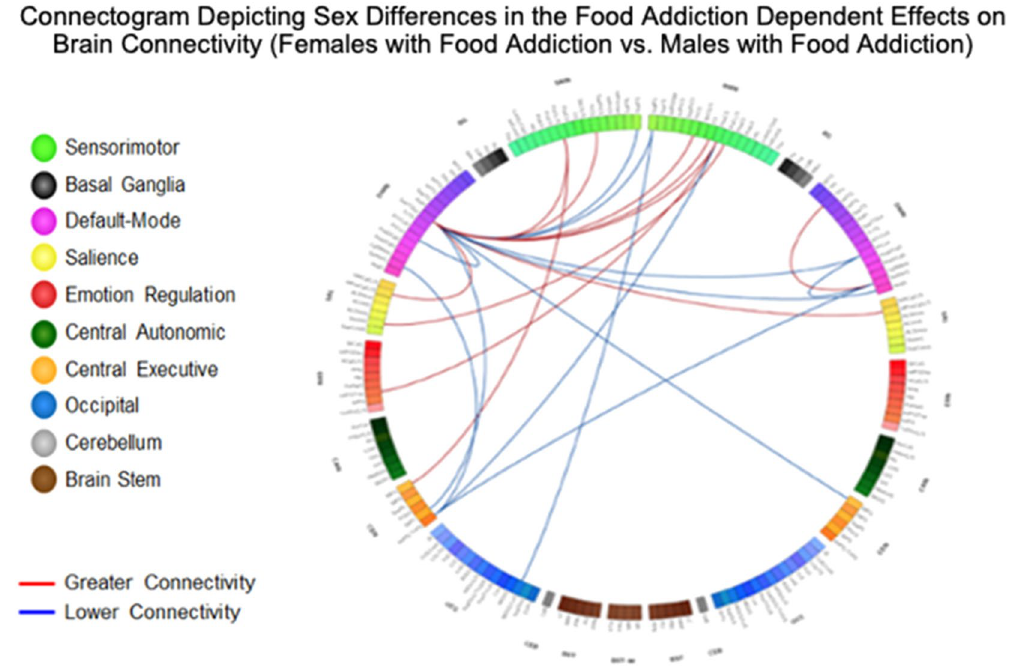
Figure 2. Connectogram Depicting Sex Differences in the Food Addiction Dependent Effects on Brain Connectivity (Females with Food Addiction vs. Males with Food Addiction). Demonstrates significant differences in functional connectivity between females with food addiction and males with food addiction. Analysis was performed Harvard–Oxford Subcortical atlases, the Schaefer 400 cortical atlas, and the Ascending Arousal Network brainstem atlas. Labels on the diagram are Destrieux, Harvard–Oxford Subcortical atlases, and the Ascending Arousal Network brainstem atlas equivalents. Red lines between two networks indicate greater functional connectivity, and blue lines indicate lowered functional connectivity. All connections are significant q < 0.05. Light Green: SMN (Sensorimotor Network); Black: BG (Basal Ganglia); Purple: DMN (Default Mode Network); Yellow: SAL (Salience); Red: ERN (Emotional Regulation Network); Dark Green: CAN (Central Autonomic Network); Orange: CEN (Central Executive Network); Blue: OCC (Occipital); Gray: CeB (Cerebellum); Brown: BST (Brain Stem). AngG, Angular gyrus; CEN, Central Executive Network; CS, Central sulcus (Rolando’s fissure); DMN, Default Mode Network; ERN, Emotional Regulation Network; InfFGTrip, Triangular part of the inferior frontal gyrus; IntPS_TrPS, Intraparietal sulcus(interparietal sulcus) and transverse parietal sulci; MFG, Middle frontal gyrus; MOcS_LuS, Middle occipital sulcus and lunatus sulcus; MPosCgG_S, Middle-posterior part of the cingulate gyrus and sulcus; PaCL_S, Paracentral lobule and sulcus; PosCG, Postcentral Gyrus; PRCG, Precentral gyrus; PrCun, Precuneus; ShoInG, Short insular gyri; Tpo, temporal pole; SAL, Salience Network SbPS, Subparietal sulcus; SMN, Sensorimotor Network; SupFG, Superior frontal gyrus; SuMarG, Supramarginal gyrus; SupTGLp, Lateral aspect of the superior temporal